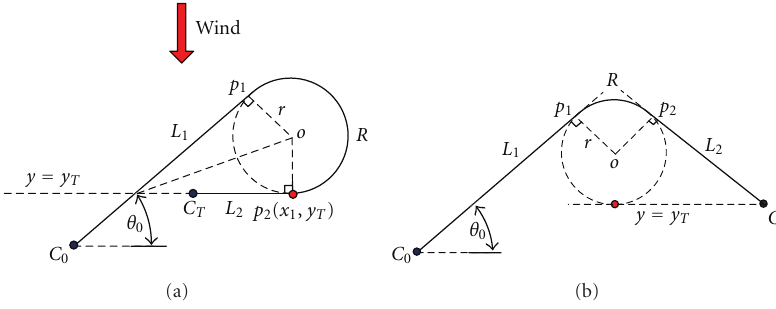
Figure 10: Wearing path between two points when θ 0 ∈ (0, π/ 2) and y T ≥ y 0 . (a) For x T < x 1 and (b) for x T ≥ x 1 .